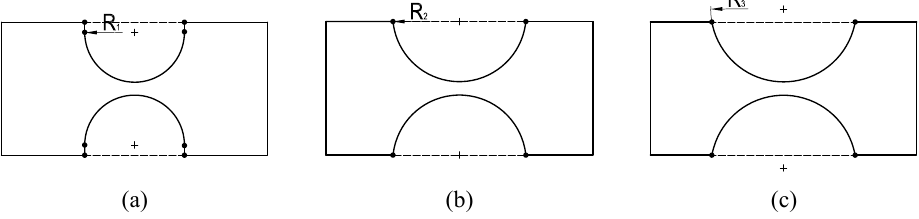
Figure 3. Three different cases for designing a circular flexure hinge in dependence of the input parameter values (all shown for β L = 2 and β h = 0 . 1): (a) 2 R < H − h (with β l < 1), (b) 2 R = H − h (right semi-circular contour, with β l < 1), (c) 2 R > H − h (with 0 < β l < β L